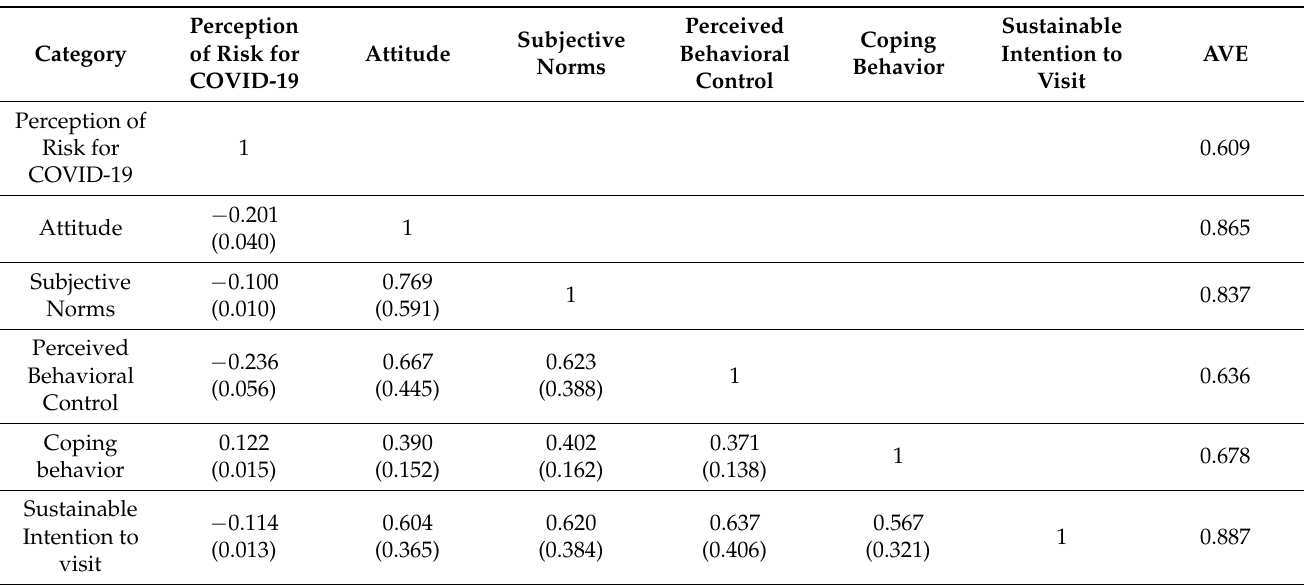
Table 3. Correlations between measurements.